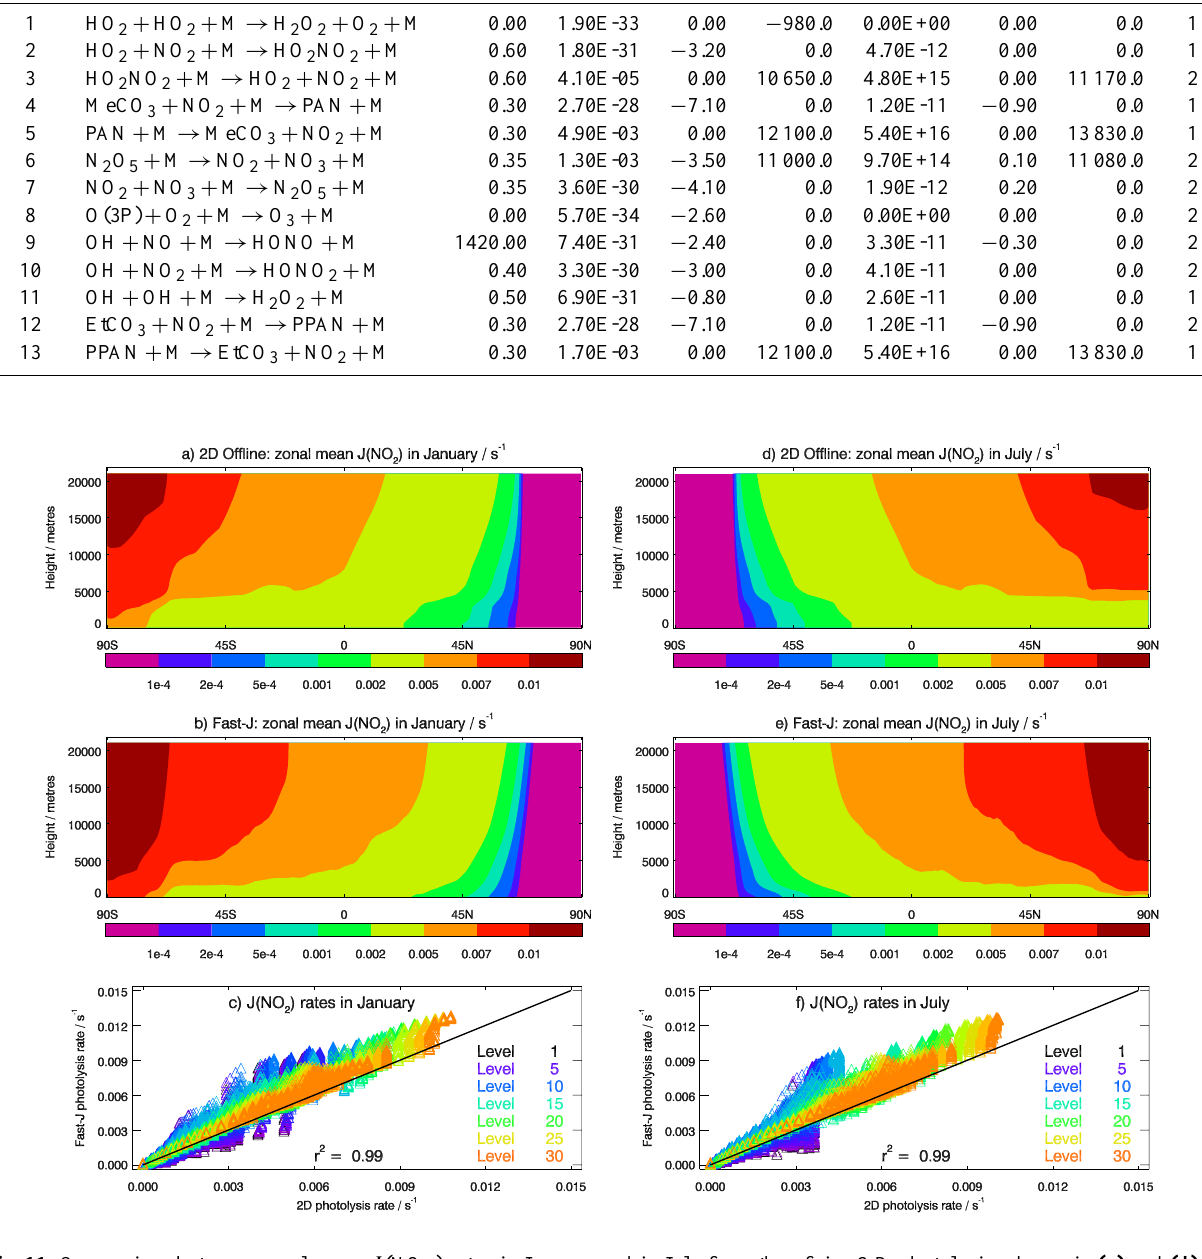
Fig. 11. Comparison between zonal mean J (NO 2 ) rates in January and in July from the offline 2-D photolysis scheme in (a) and (d) and from the online Fast-J scheme in (b) and (e) . Scatter plots of the J (NO 2 ) photolysis rate from both schemes are shown in (c) and (f)